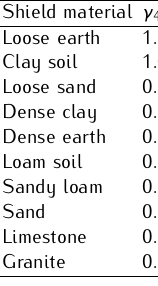
Table 4. Parameter γ